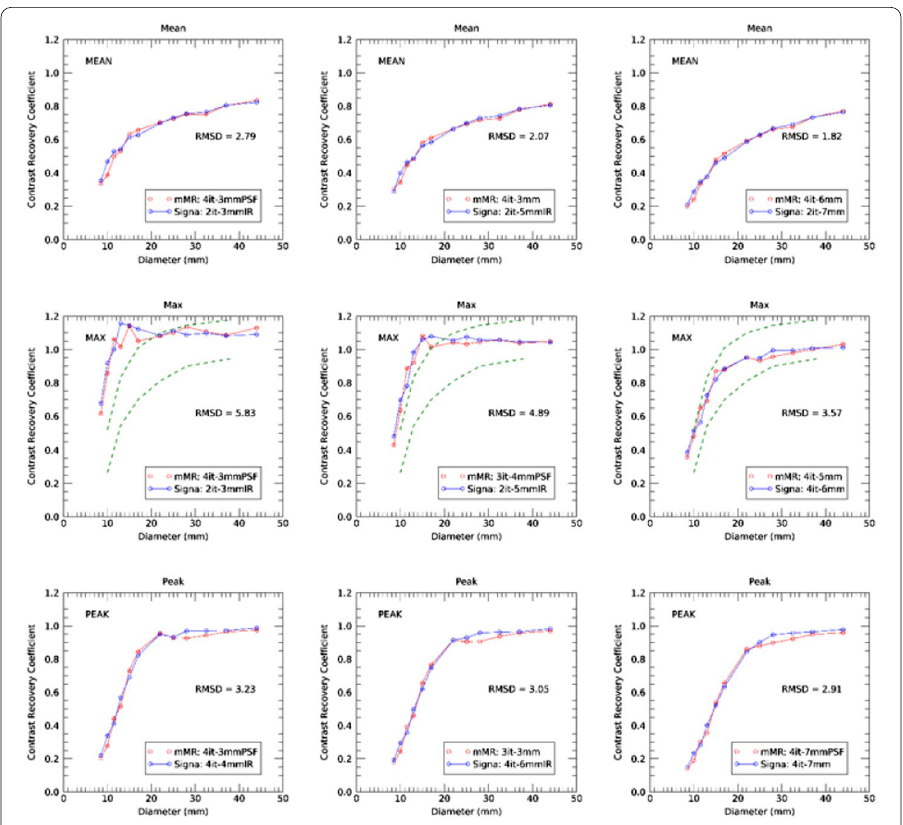
Fig. 5 Matching CRC curves for mean (top), max (middle) and peak values (bottom) for 30 min of data corresponding to three optimization scenario: (left) optimized for best resolution or highest CRC values, (middle) optimized for both resolution and RMSD and (right) for best RMSD. The corresponding RMSD values are indicated in each panel. Results from the Siemens Biograph mMR are in red and from the GE Signa are in blue. The dashed lines represent the EANM limits on CRC max